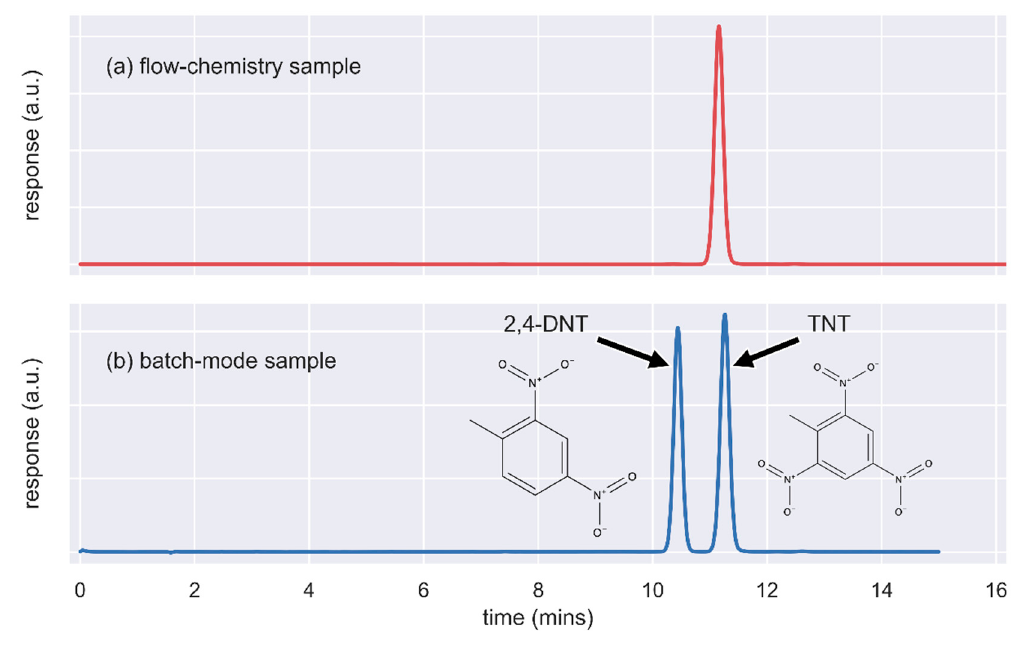
Figure 4. Chromatograms of HPLC-DAD analysis of the product obtained after 2,4-DNT nitration using ( a ) flow chemistry and ( b ) batch mode.